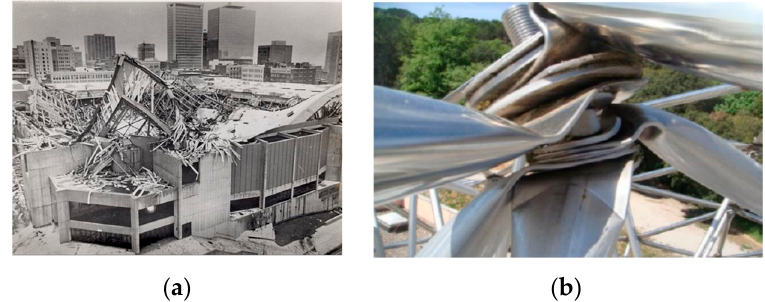
Figure 4. Collapse detail with space truss, ( a ) details of the collapse of the Hartford Civic Center Coliseum [25], ( b ) cover collapse after a snowfall in Gerona, Spain [49].